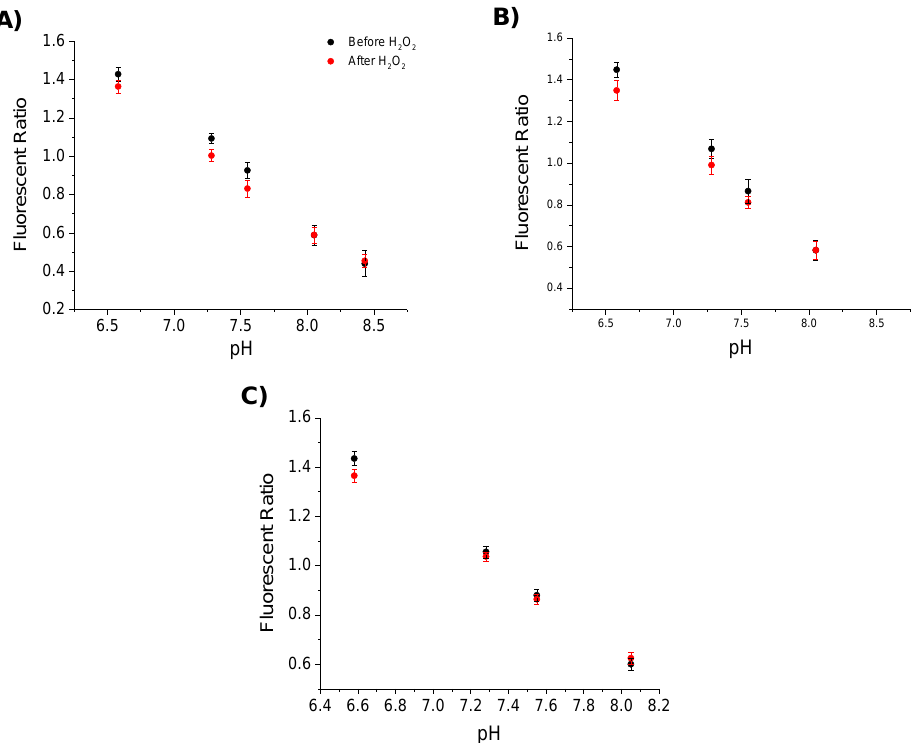
Figure 6. Sensing of pH before and after immersion in H 2 O 2 . Each graph plots the ratio of emission peaks of SNARF2 at 600/660 nm with the pH of the buffer solution tested, before and after solutions: ( A ) 100 µ M solution of H 2 O 2 in pH 7.55 buffer; ( B ) 50 µ M H 2 O 2 in pH 7.55 buffer; ( C ) 100 µ M H 2 O 2 in pH 7.05 buffer. Three different samples were trialled before and after H 2 O 2 solutions to demonstrate the independence of the result to concentration of H 2 O 2 or the pH of the H 2 O 2 solution. To reduce any effect of noise, the mean of eight values between 598–602 nm and 558–662 nm is given. Error bars represent the standard deviation of these